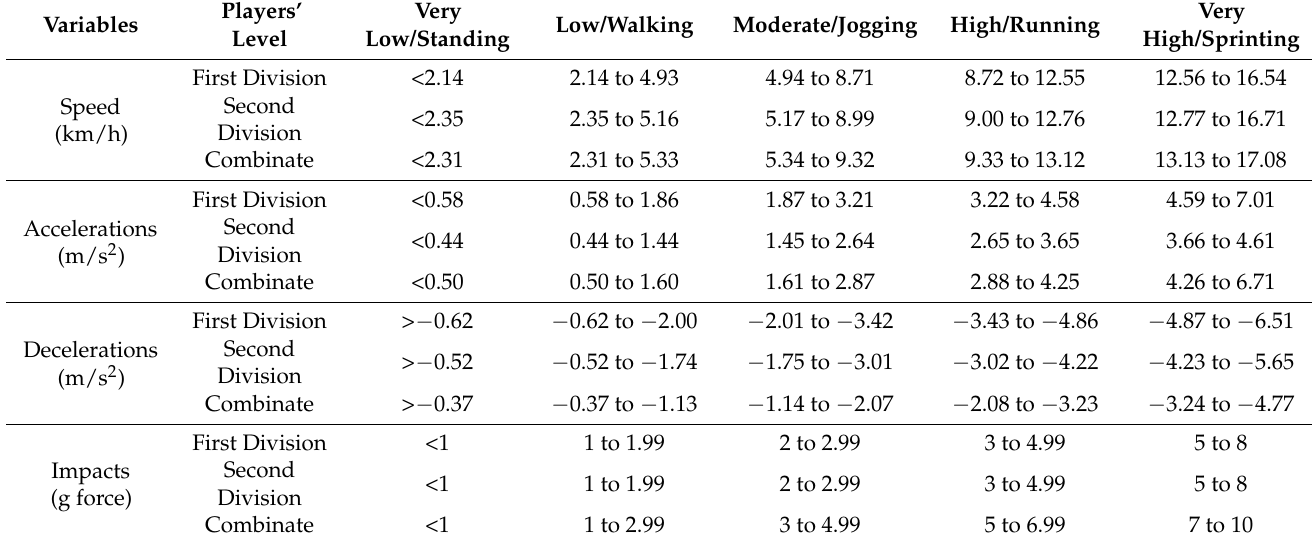
Table 1. Thresholds of external workload variables in female basketball according to competitive level.